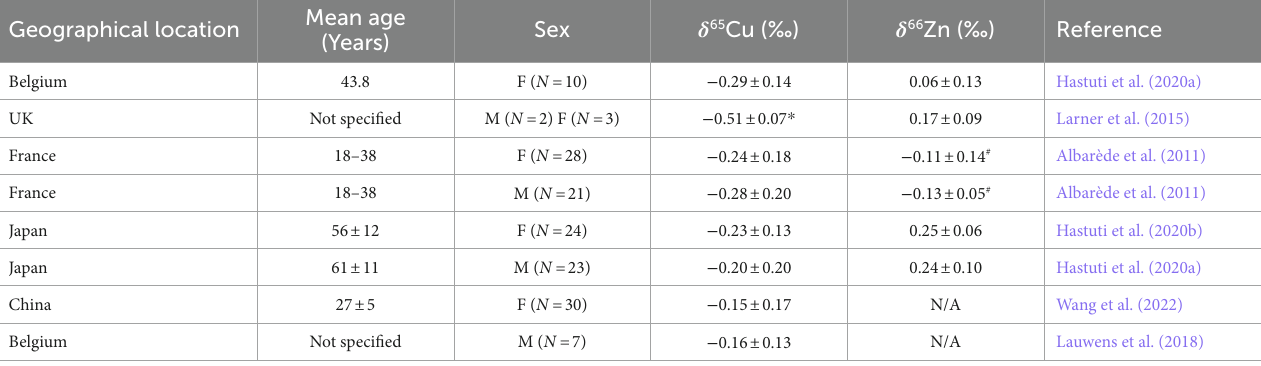
TABLE 4 A survey of the copper and zinc isotopic composition of healthy adults in various geographical regions.